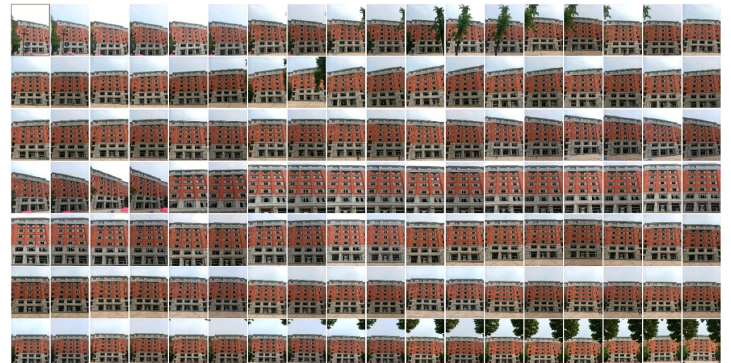
Figure 10. Samples from HFUT dataset. Appl. Sci. 2019 , 9 , x FOR PEER REVIEW